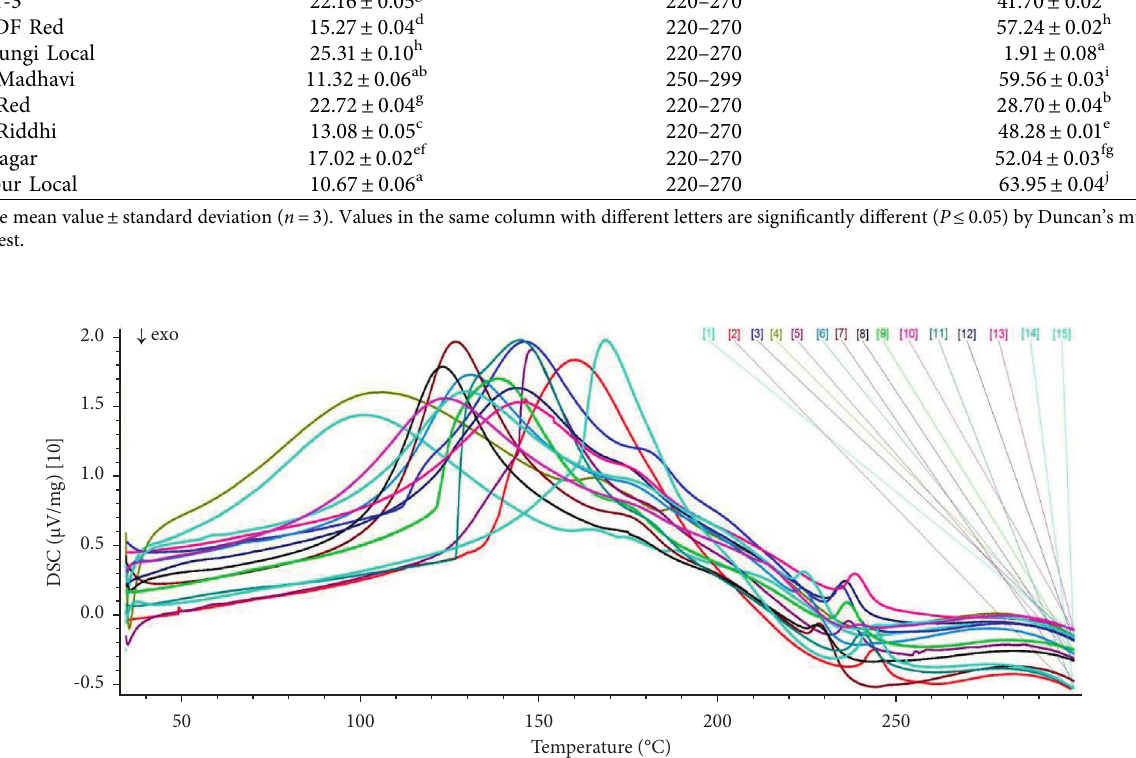
Figure 4: Combined differential scanning calorimetry curve of onion skin powder of fifteen cultivars: 1, Agrifound Dark Red; 2, Agrifound Light Red; 3, Arka Kirthiman; 4, Bhima Kiran; 5, Bhima Shakti; 6, Bhima Shubhra; 7, Hissar-2; 8, Hissar-3; 9, NHRDF Red; 10, Phursungi Local; 11, Pusa Madhavi; 12, Pusa Red; 13, Pusa Riddhi; 14, Sukhsagar; 15, Udaipur